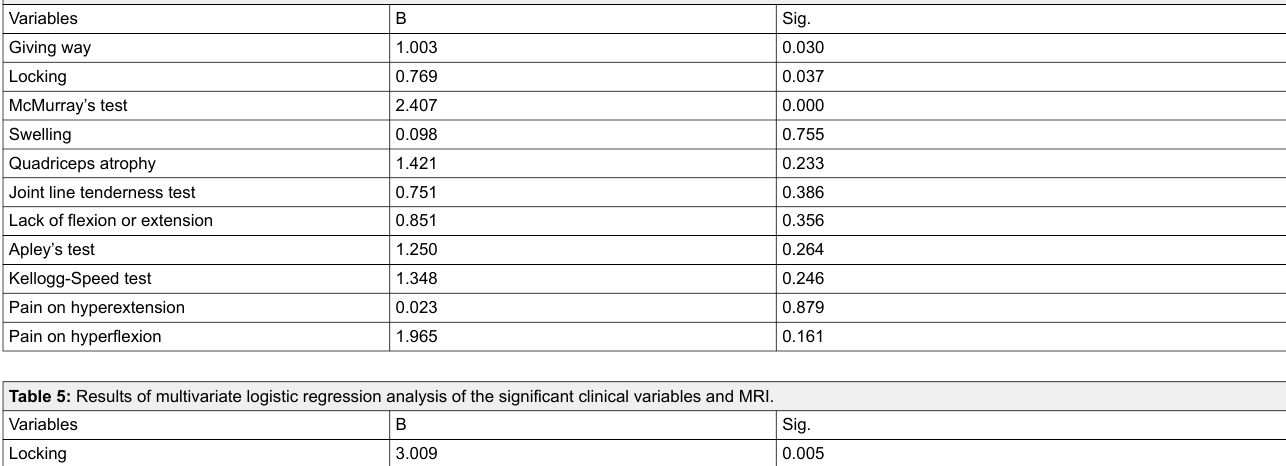
Table 4: Results of multivariate logistic regression analysis of the significant clinical variables. Variables B Sig.